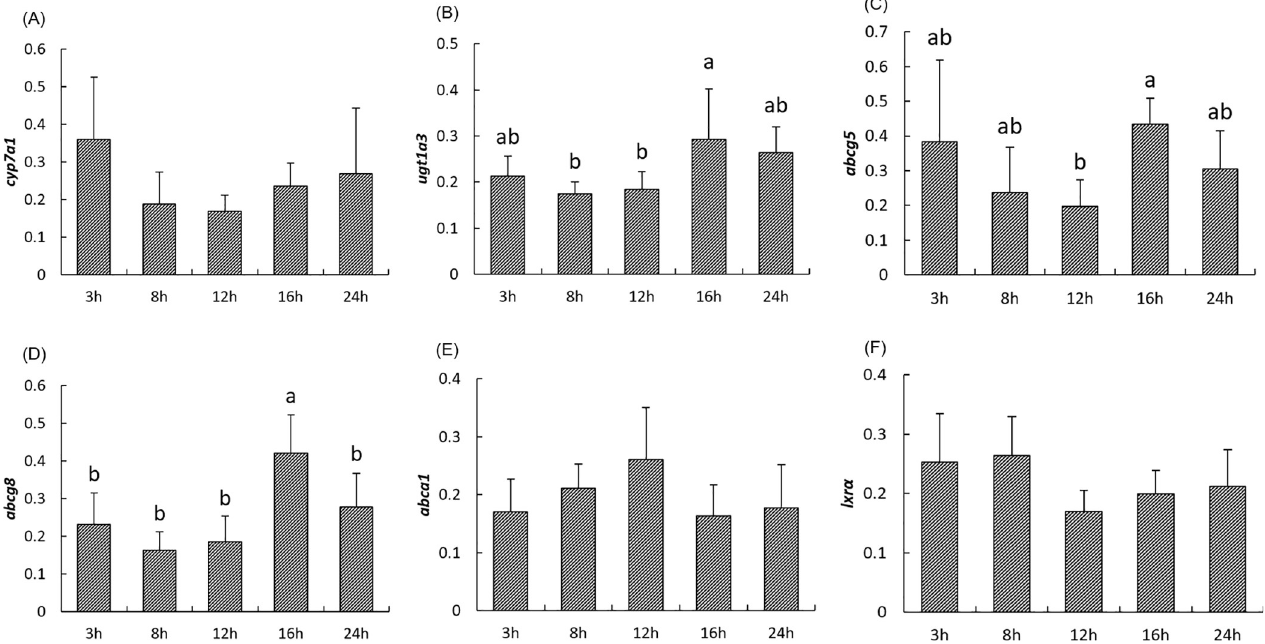
Fig 3. Postprandial expression of genes involved in cholesterol efflux including cyp7a1 (A) , ugt1a3 (B) , abcg5 (C) , abcg8 (D) , abca1(E) lxr α (F) in the liver of rainbow trout at 3h, 8h, 12h, 16h and 24h after the meal. The NORMA-Gene method was used for the normalization. Values are means (n = 6), with their standard deviations represented by vertical bars. a, b Mean values with unlike letters were significantly different ( P < 0.05; One-way analysis of variance, Tukey’s test).